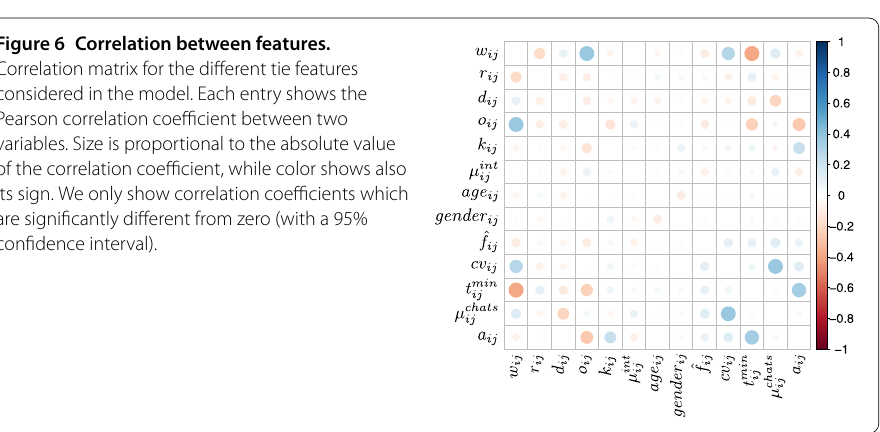
Figure 5 Distribution of features. Histograms of the different features considered in our models. Each row of histograms correspond to a different group of features: intensity, structure, intimacy and temporal features from top to bottom. Note that as mentioned in the text, some variables are log-transformed, specifically w ij , d ij , ˆ f ij , cv ij and t min ij .